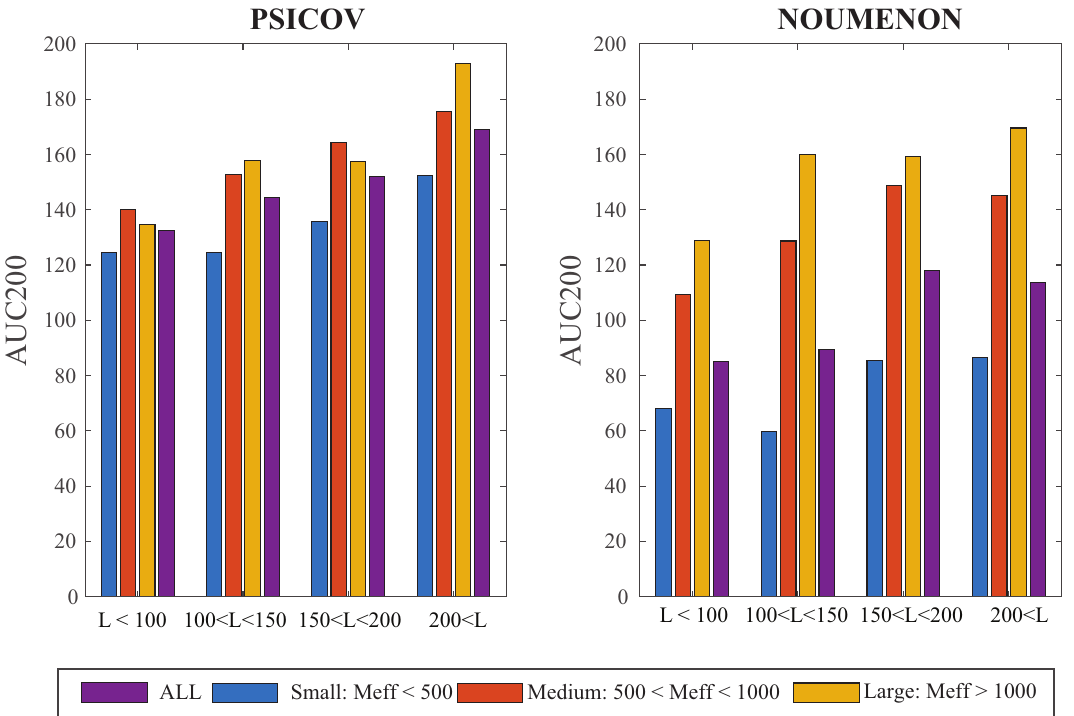
Figure 3. AUC200 plotted against the lengths of the multiple sequence alignments, for different groups of sizes of those alignments, for the PSICOV dataset ( left ) and the NOUMENON dataset ( right ). All computations are done with Gauss20, with λ = 0.8. Results are shown over all three groups of MSAs with respect to size (see legend of Figure 2 for their definitions), as well as over four groups of MSA lengths ( x